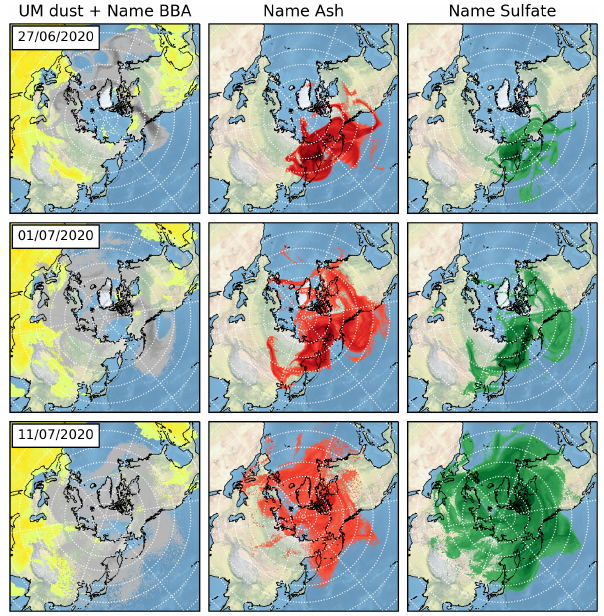
Figure 10. NAME dispersion model simulations for BBA (black/grey) (with UM dust field in yellow), ash (red) and sulfate (green). Data for 00:00UTC on date indicated in each